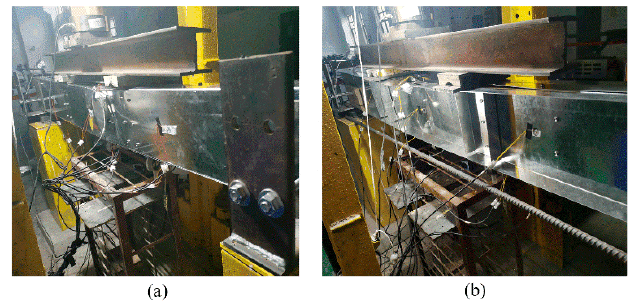
Figure 7. Failure modes. ( a ) B4 Beam; ( b ) K4 Beam.